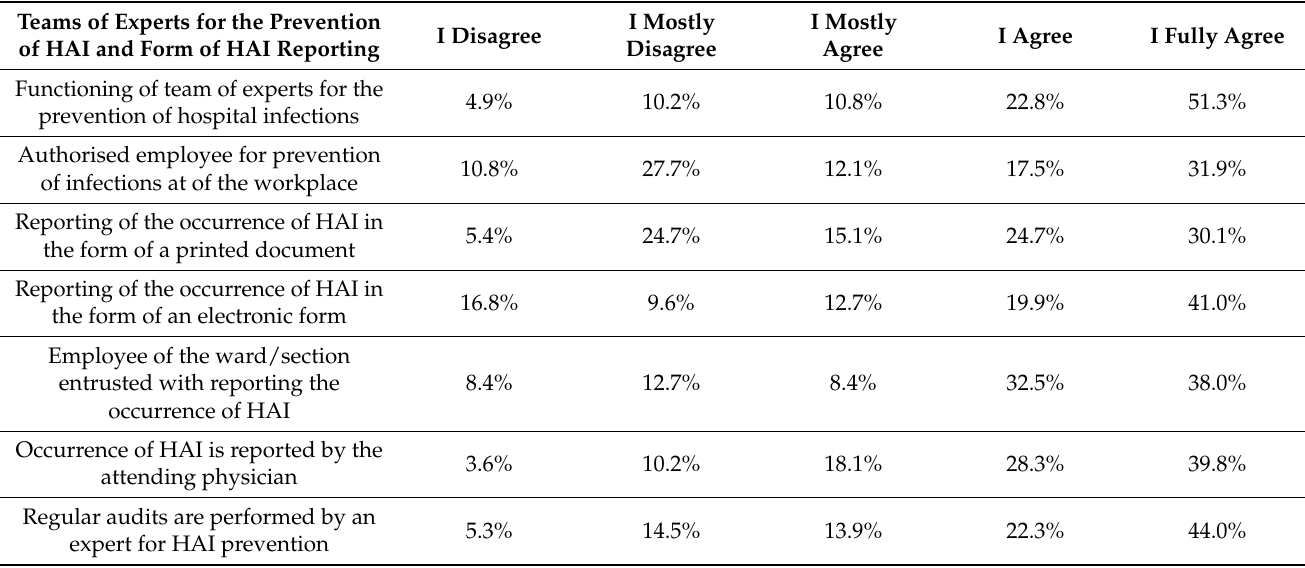
Table 8. Responses to items related to the functioning of the HAI prevention expert or team and the form of HAI